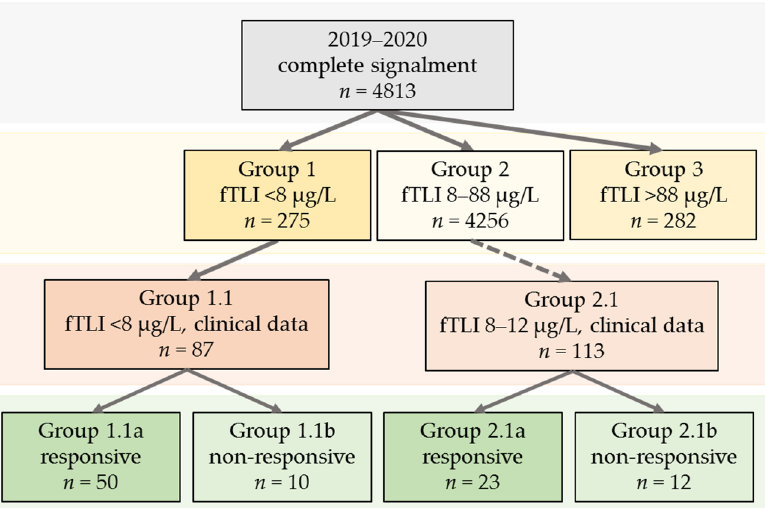
Figure 2. Overview of the analysed data sets and groups. The cases from 2019–2020 were divided into groups 1–3 according to their serum fTLI concentration. Groups 1.1 and 2.1 represent animals with known clinical data. Group 2.1 included data from cats with serum fTLI concentrations in the lower reference interval (8–12 µg/L). In the next step, cats from groups 1.1 and 2.1 were divided into responsive (groups 1.1a and 2.1a) and non-responsive (groups 1.2b and 2.1b) to treatment with pancreatic enzymes.